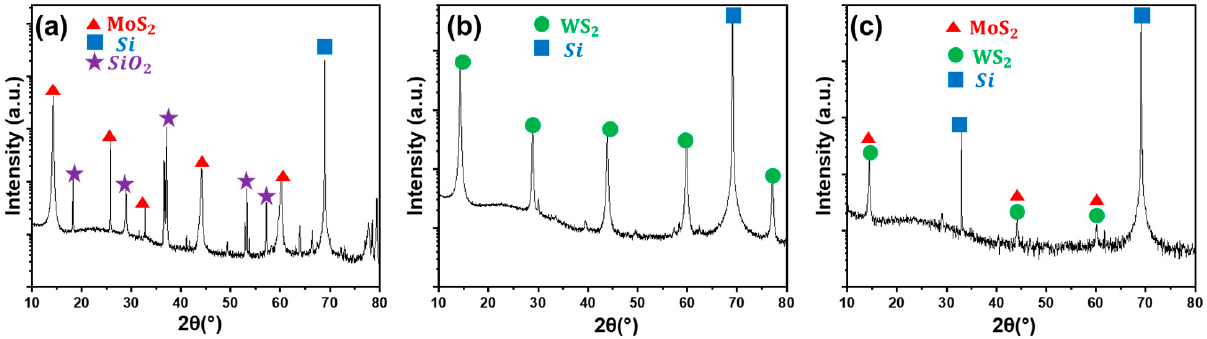
Figure 3. XRD diagrams recorded for the as-grown ( a ) MoS 2 , ( b ) WS 2 and ( c ) Mo x W 1-x S 2 . For the Mo x W 1-x S 2 heterostructure, the MoS 2 and WS 2 peaks are present in the corre- sponding XRD diagram given in Figure 3c. This confirms the successful fabrication of the heterostructure. The sharp diffraction peaks observed on the spectra are a clear indication of the high crystallinity of the fabricated nanosheets. The SEM images show different morphologies for the MoS 2 , WS 2 and the heterostruc- ture samples. The MoS 2 flakes (Figure 4a) are observed to grow vertically. This is high- lighted at a higher magnification in Figure 4b. Similar results were reported previously [32]. On the other hand, WS 2 shows accumulated crystals stacked on top of the substrate. A large number of triangular shaped flakes disposed horizontally are visible in Figure 4c,d at low and high magnifications,